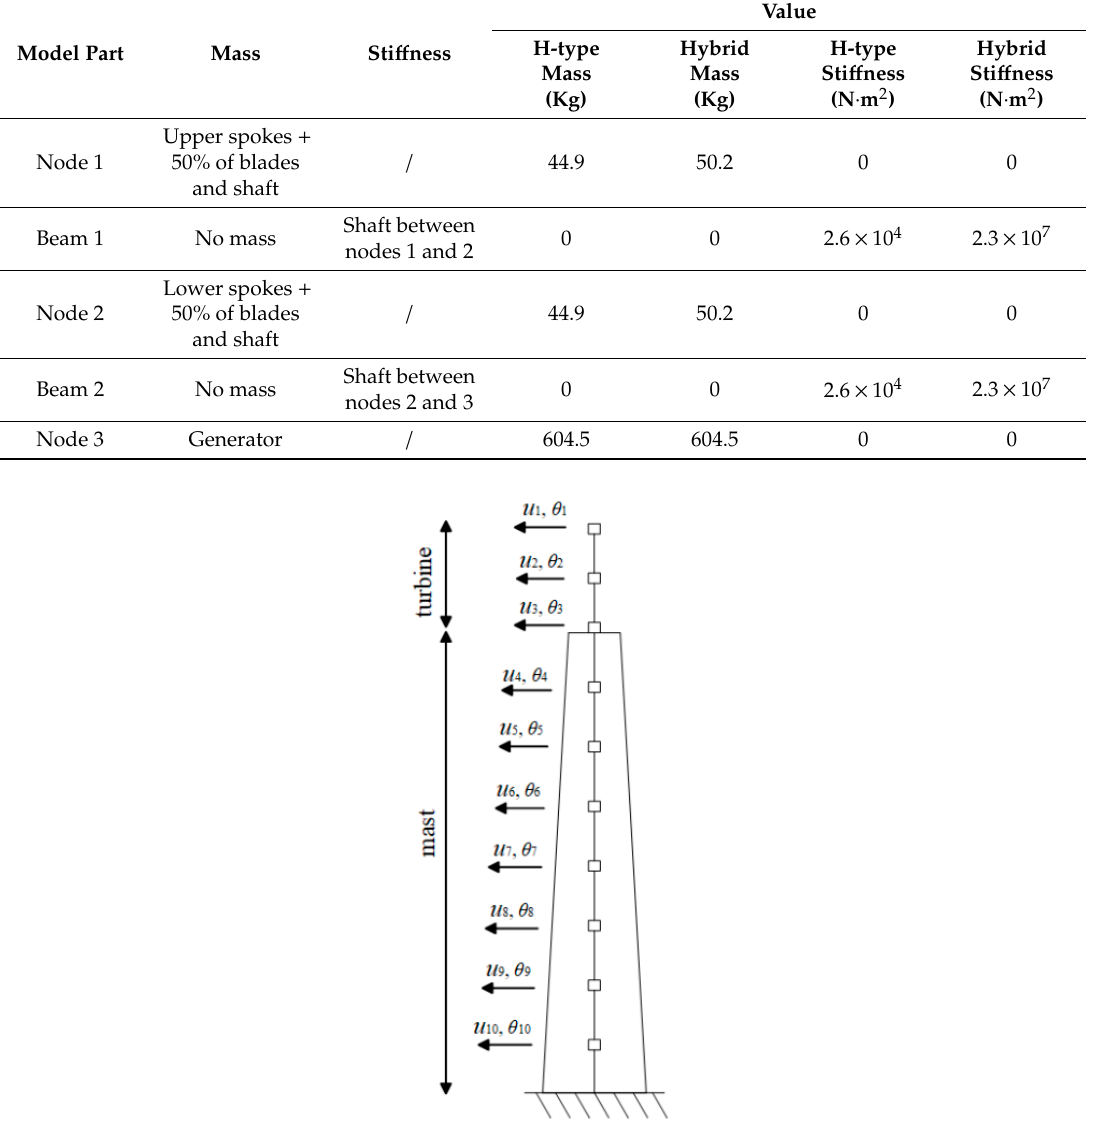
Figure 6. Simpler MDOF model of the VAWTs with only three nodes. By applying unit displacements and rotations, force and moment balance equations for all the elements are established: